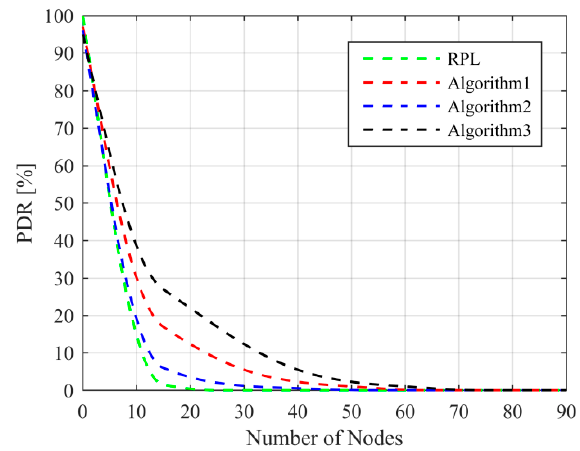
Figure 11. PDR (Packet Deliver Rate) in different network siz e.